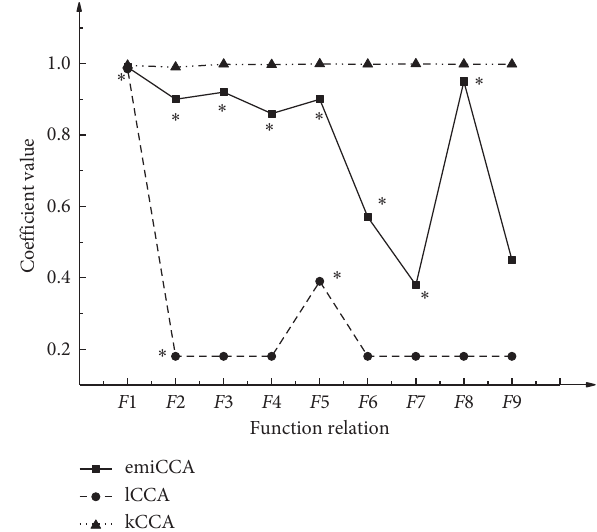
Figure 6: Coefficient changes of emiCCA, lCCA, and kCCA corresponding to different function